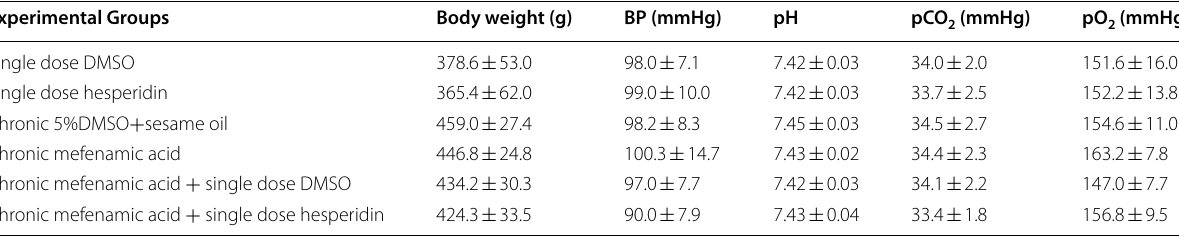
Table 1 Systemic physiology Experimental